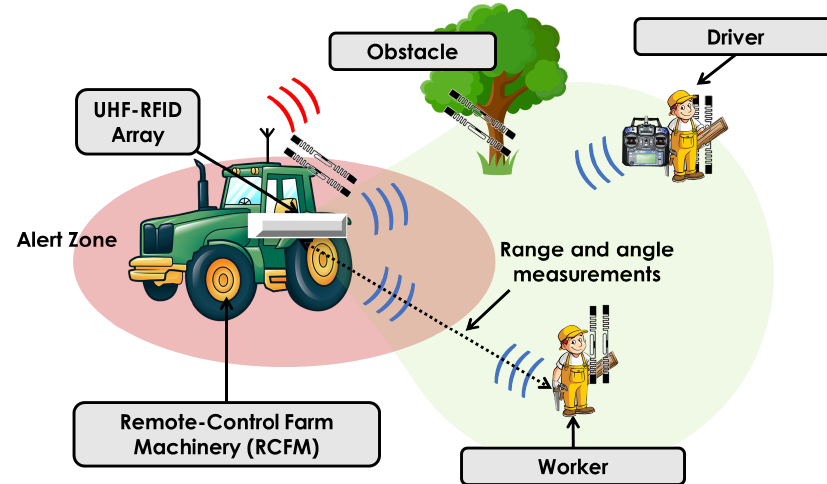
Figure 1. Operating outdoor scenario of the SMARTGRID